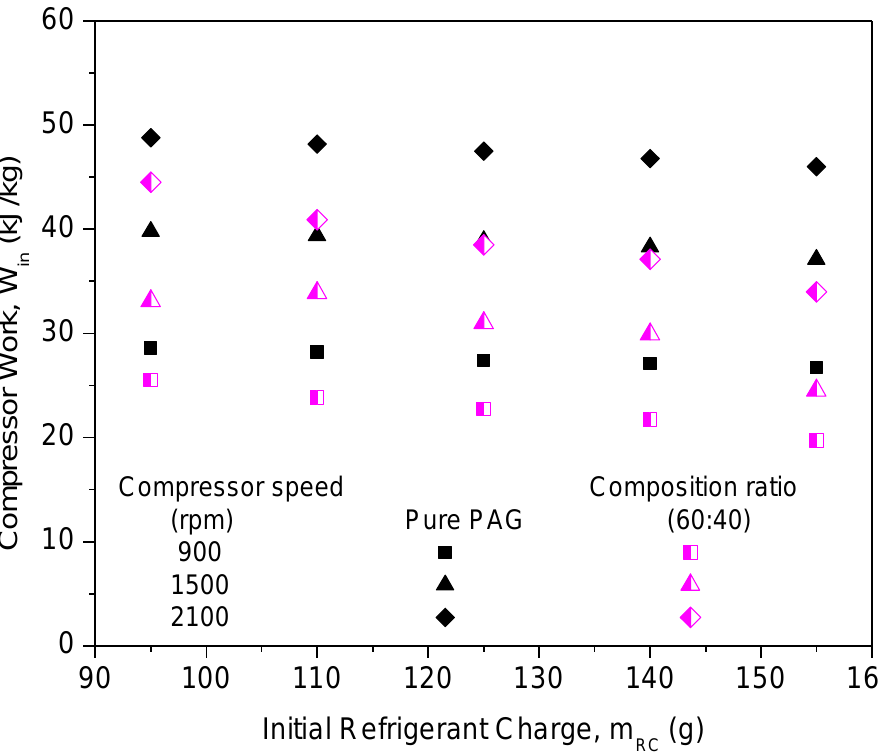
15 of 19 Figure 12. Cooling capacity of the hybrid nanolubricants at the optimum 60:40 composition ratio. Figure 13 represents the effects of compressor work at different compressor speeds for Al 2 O 3 -SiO 2 /PAG at the 60:40 ratio. When compared to the pure PAG lubricants, the compressor work for hybrid nanolubricants was significantly less. In addition, when the refrigerant charge rises, the compressor ’ s workload diminishes. Low compressor speed is thought to result in less load on the compressor, resulting in less compressor effort com- pared to greater compressor speed. When compared to the pure PAG, Al 2 O 3 -SiO 2 /PAG contributes more to lowering the compressor effort. This is because of a decrease in the tribological behavior of hybrid nanolubricants, specifically the friction coefficient and the percentage of wear. Thus, in order to reduce the compressor friction losses, which lower the pressure drop and compressor effort, hybrid nanolubricants are required in the refrig- eration systems. The hybrid nanolubricants are being considered since a higher coefficient friction results in greater friction losses. Figure 14 shows a graph of COP against the initial refrigerant mass of the system at different compressor speeds for the 60:40 ratio. The graph indicates that COP improves as the refrigerant charge increases, but declines as the com- pressor speed increases. The graph depicts a low COP for the pure PAG lubricants. This is because the pure PAG lubricants have low cooling capacities but high compressor work. The maximum COP achievable was 8.81 for Al 2 O 3 -SiO 2 /PAG of the 60:40 ratios at the 155 g refrigerant charge and 900 rpm. Sabareesh et al. [54] and Kumar and Elansezhian [32]